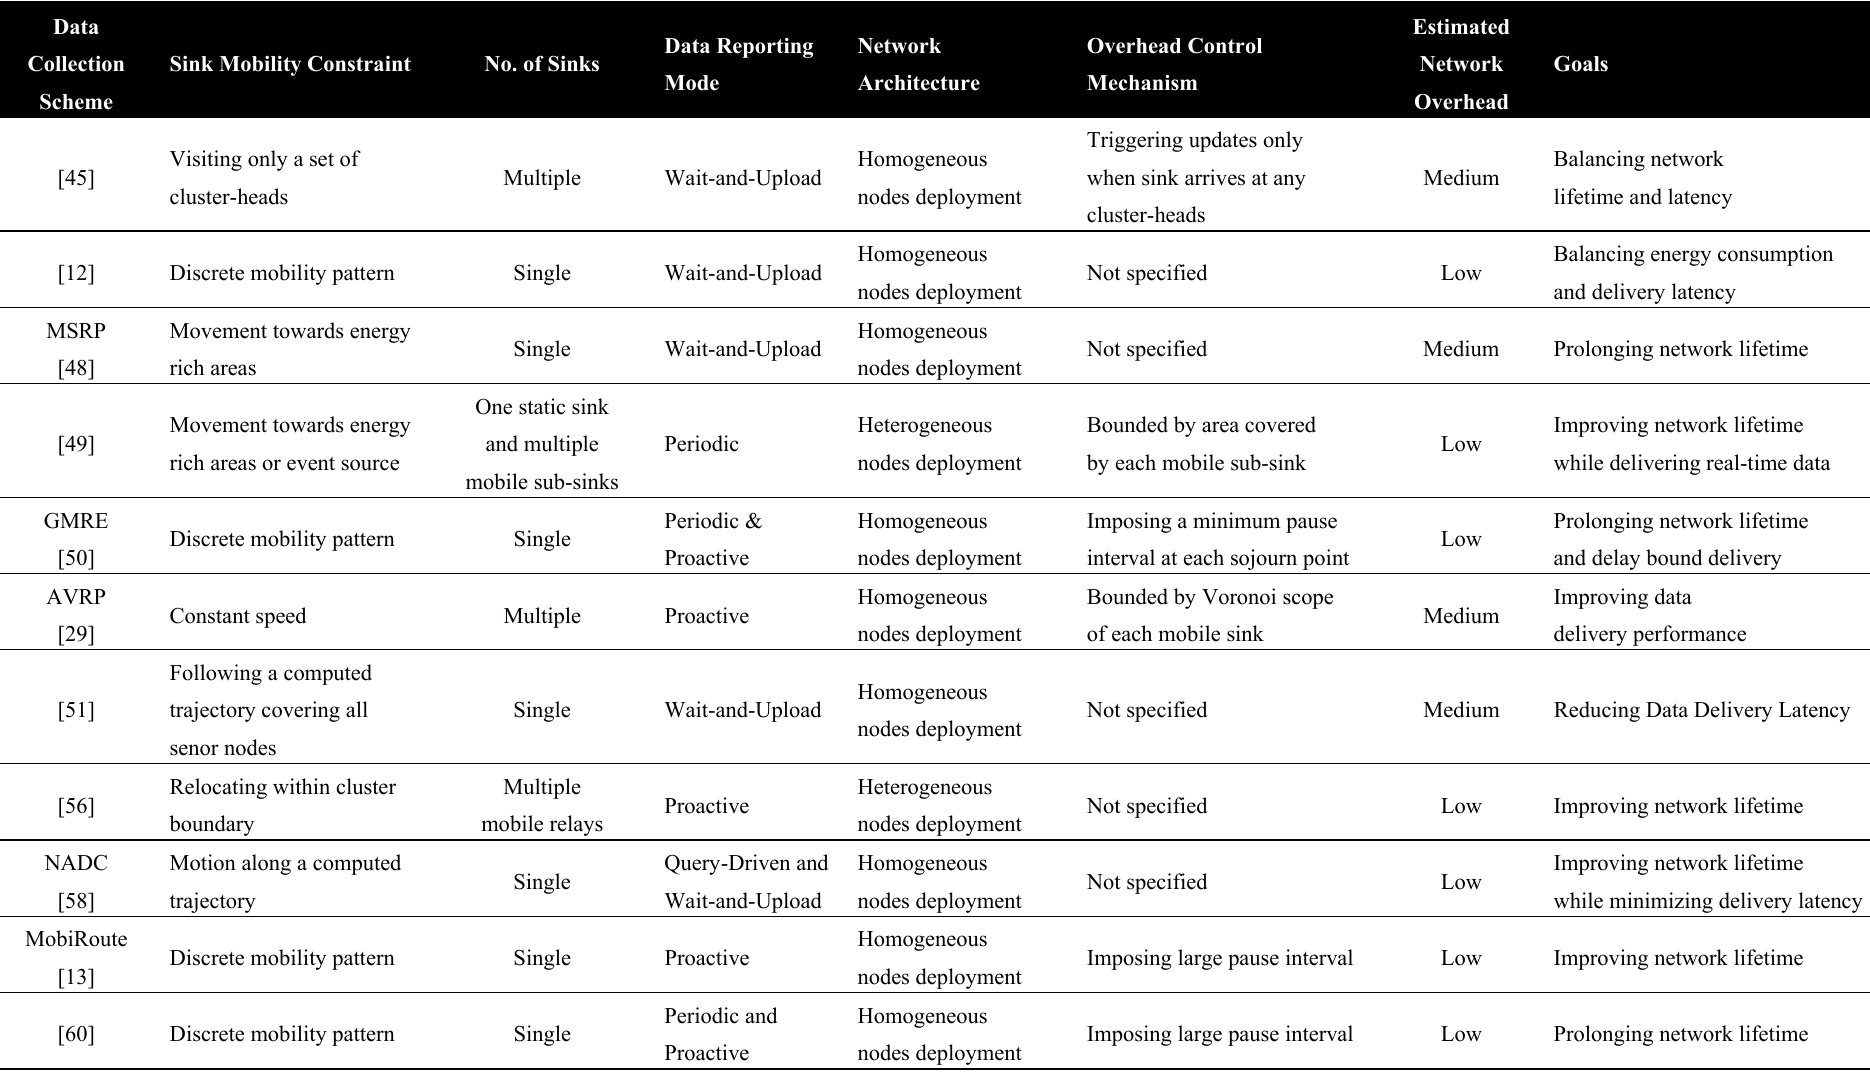
Table 3. Summary of controlled sink mobility based data collection